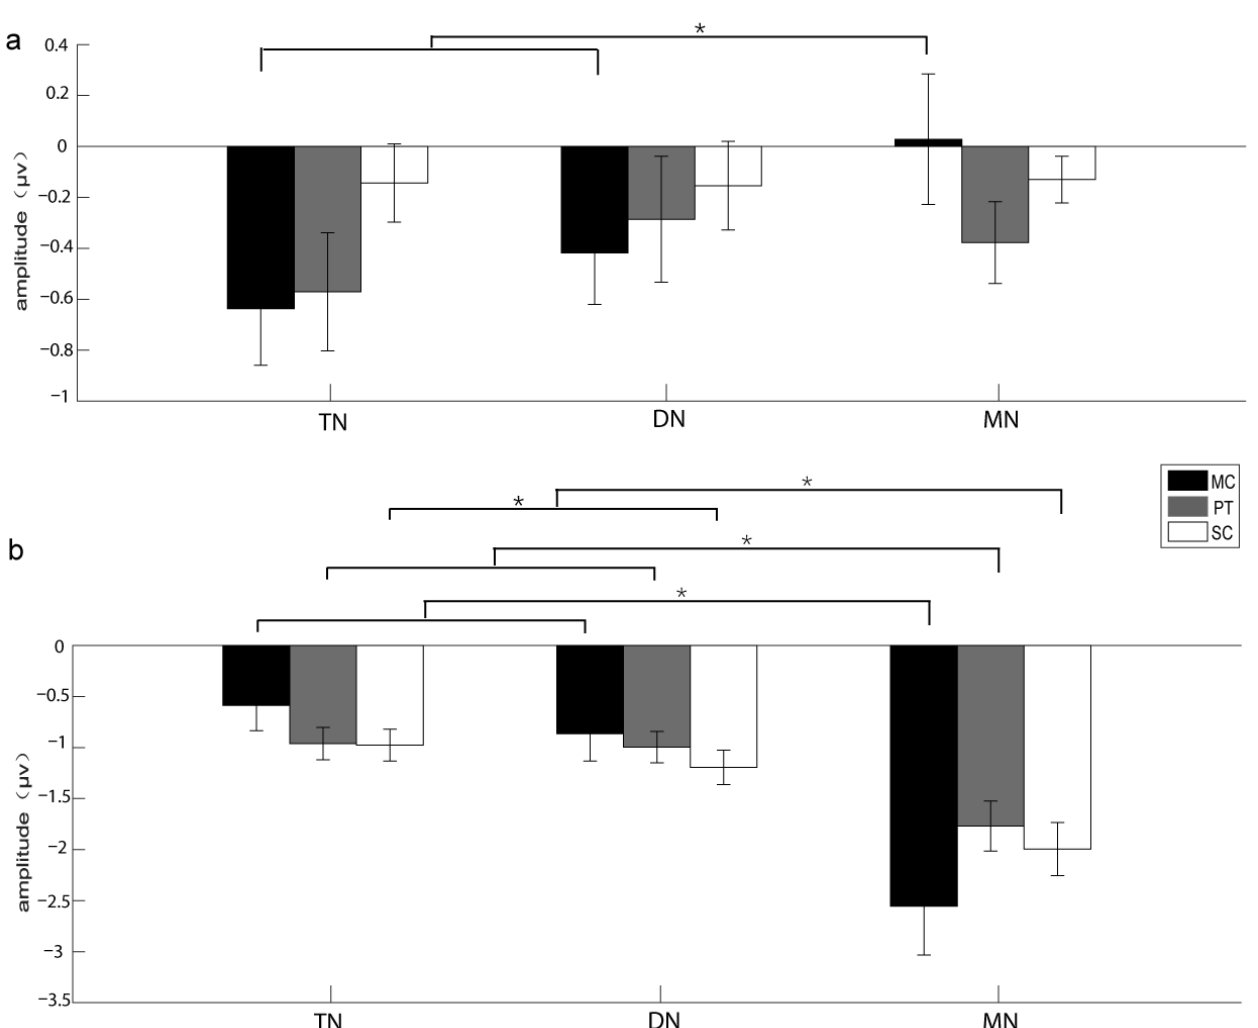
Figure 3. The amplitudes and standard errors of SPN ( a ) and N1 ( b ) components for the experiments recruiting voluntary attention. Each asterisk (*) indicates significant differences among different brain areas ( p < 0.05). Note that SPN was acquired from superimposition of the recorded waveforms according to the onset of white noise before silence replacement, while N1 was acquired from superimposition of the recorded waveforms with respect to the onset of the target stimuli. MC, conspecific male advertisement call; PT, 1000 Hz pure tone; SC, screech call; TN, telencephalon; DN, diencephalon; MN, mesencephalon.